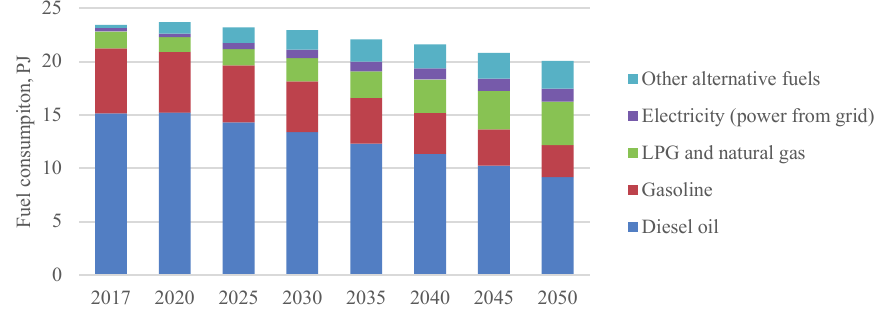
Fig. 10. Fuel consumption for land passenger transportation in NECP